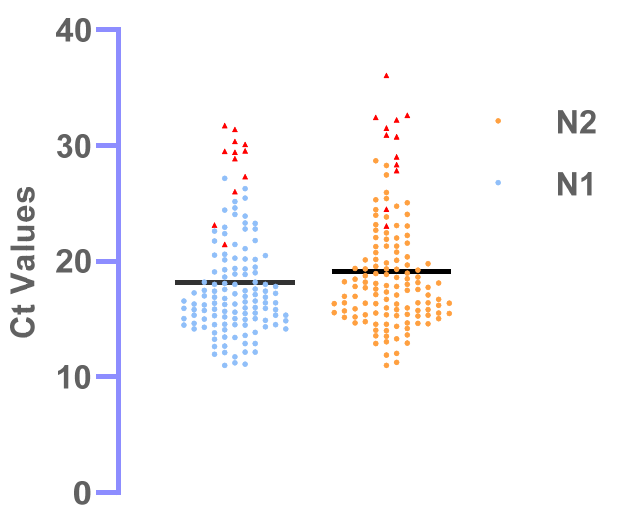
Figure 2. Scatter diagram showing distribution of RT-PCR positive patients for the SARS-CoV-2 N1 and N2 targets with individual Ct values. The red triangles represent the RT-PCR positive samples that have been missed by the Onsite ® COVID-19 Ag RDT.